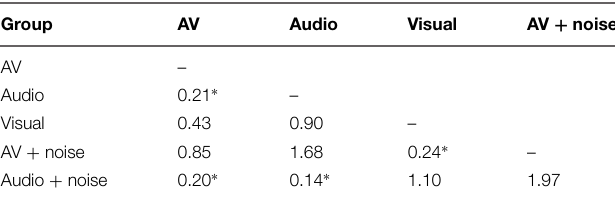
TABLE 3 | Bayes factor ( B ) for comparisons of adaptation between groups in Study 1.